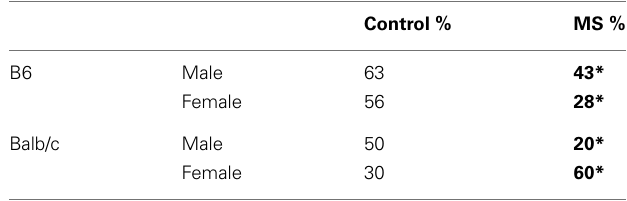
Table 1 | Percentage of mice exhibiting sucrose